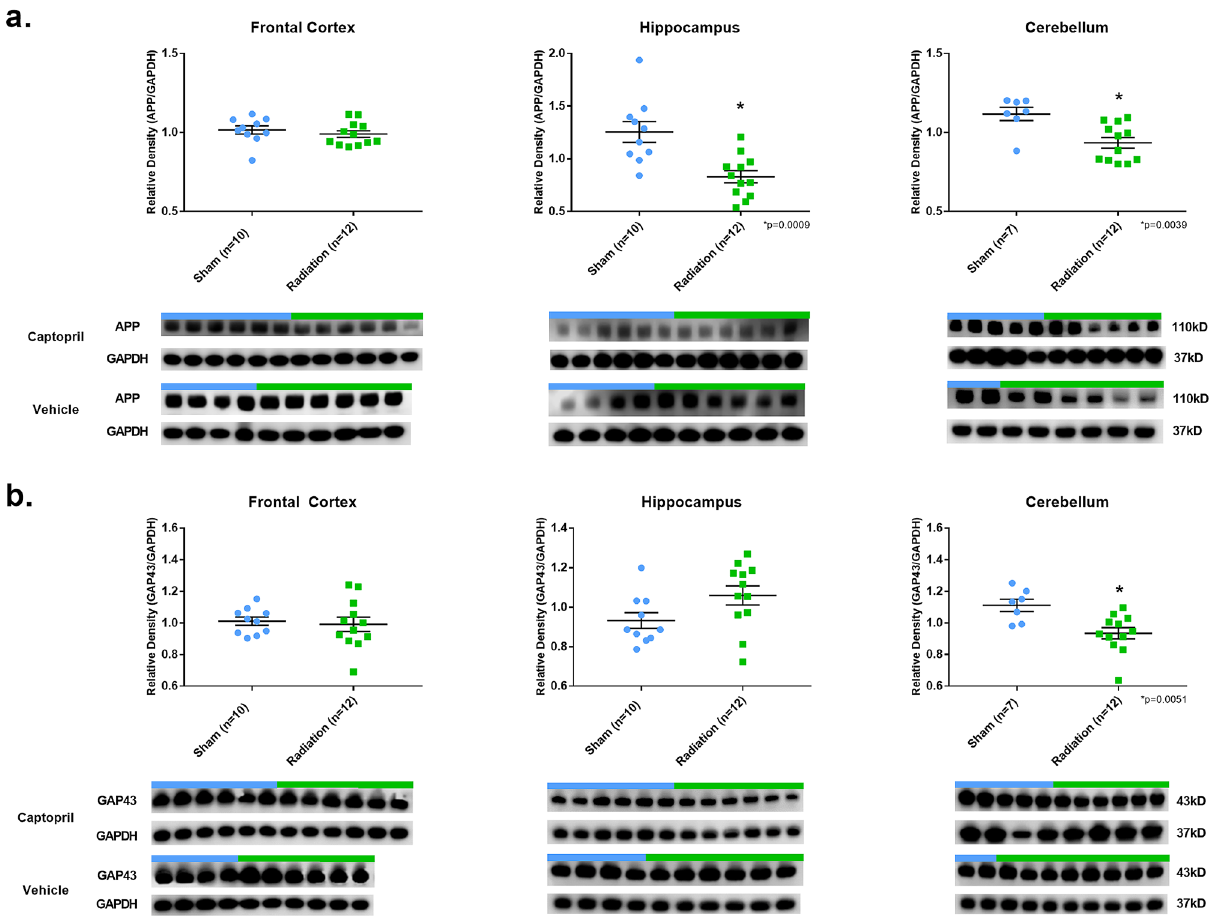
Figure 3. APP and GAP43 expression in brain following total body radiation. Histograms representing the densitometric ratio of levels of APP ( a ) and GAP43 ( b ) with respect to GAPDH as measured in the frontal cortex, hippocampus and cerebellum in the brains of Gottingen mini-pigs 30-days after total body radiation (1.79 Gy of Cobalt [ 60 Co]) with representative western blots # for sham and radiation exposed animals treated with captopril or vehicle. There was no statistical difference between captopril or vehicle treated groups, so data was pooled for each group represented in histograms above. * indicates p values < 0.05 as determined by 2-tailed, unpaired, t-tests. Error bars represent standard error of the mean (SEM). # for full length blots for each antibody, see Supplementary Fig.